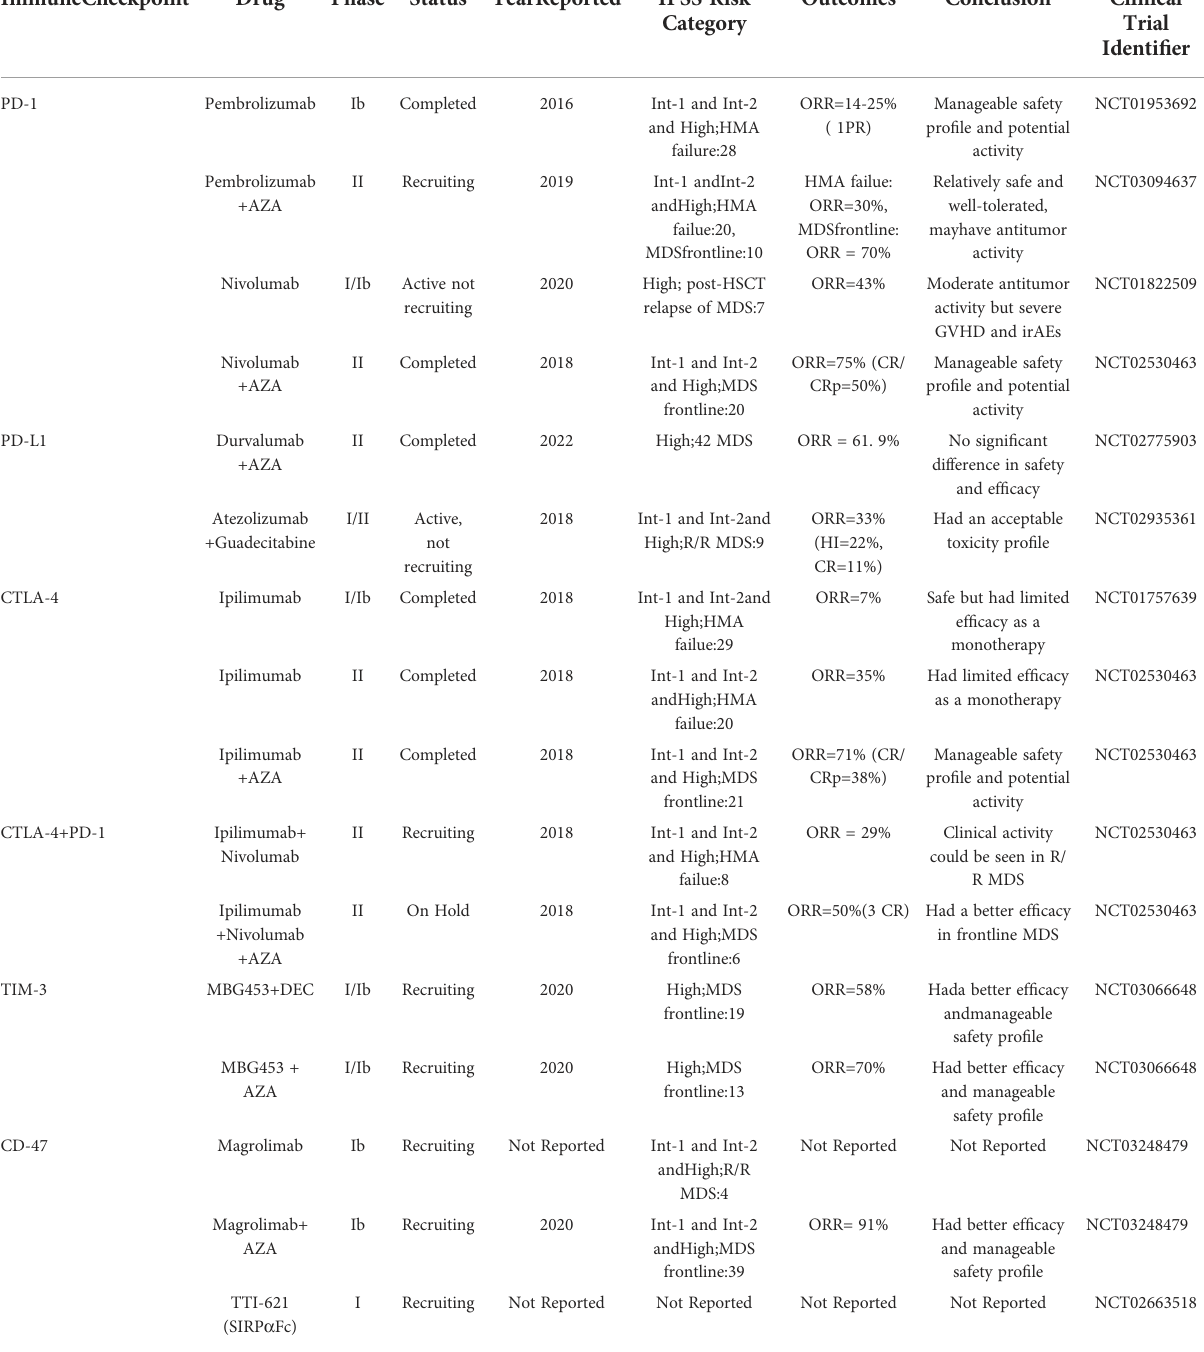
TABLE 2 Clinical trials of immune checkpoint inhibitor in MDS.